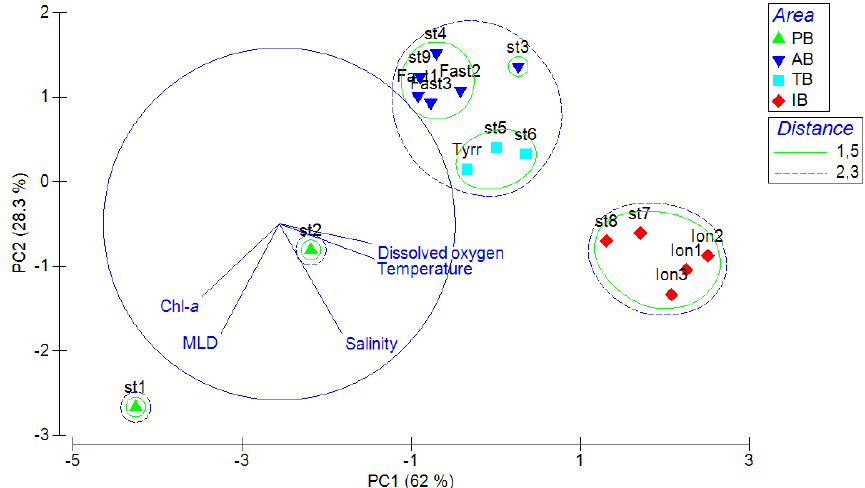
Figure 3. Principal component analysis (PCA) ordination of five environmental indicators: mixing layer depth (MLD), integrated values of the Chl- a concentration, and mean values in the upper 0 −− 300m for temperature, salinity, and dissolved oxygen. AB refers to the Algerian Basin, PB refers to the Provencal Basin, TB refers to the Tyrrhenian Basin, and IB refers to the Ionian Basin. Table 3. Table summarizing the Spearman’s rank correlations. T ◦ represents temperature, Sal represents salinity, Chl- a represents chloro- phyll, MLD represents the mixing layer depth, and PP represents primary production. Bold characters indicate a significant Rs value ( p< 0 .